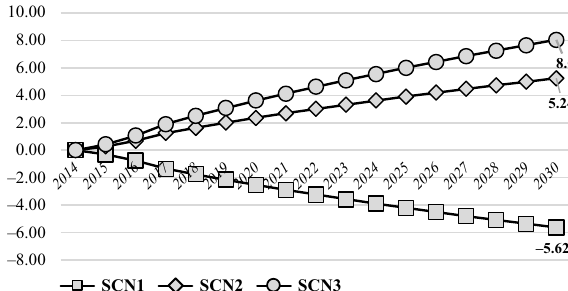
Figure 3. GDP difference from the benchmark scenario, 2014–2030